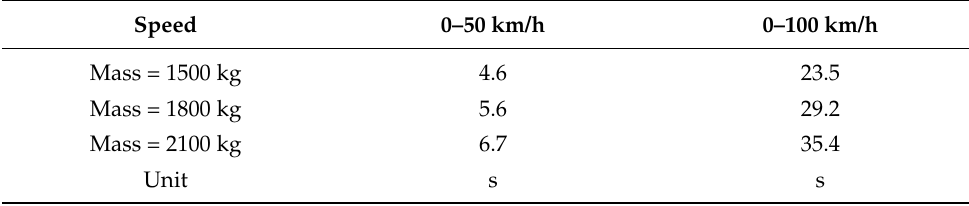
Table 12. Acceleration times for three variants of vehicle